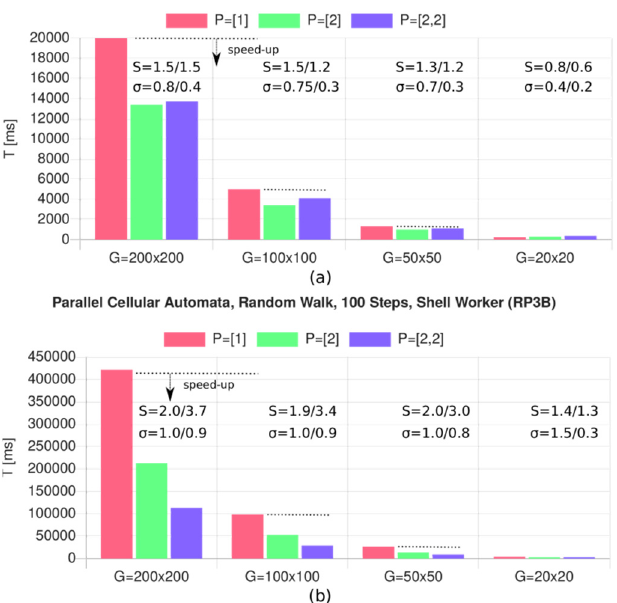
Figure 11. ( a ) Parallel simulation results using Web worker processes showing total simulation time for 100 simulation steps ( b ) Results for shell worker processes executed on an embedded computer (Raspberry PI 3+); S: speeding up, σ : scaling up.